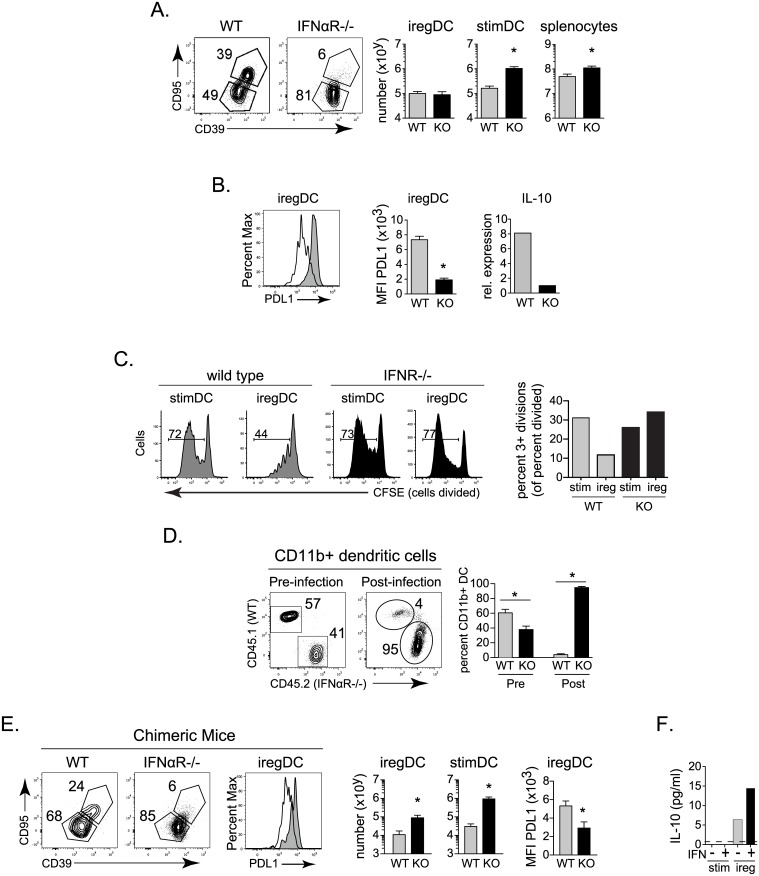
Two-pronged mechanism of IFN-I mediated immunosuppression: IFN-I programs iregDC suppressive functions and limits stimDC generation.
A. CD39 and CD95 expression by splenic CD11b+ DCs from WT and IFNαR-/- mice at day 9 after LCMV-Cl13 infection. Bar graphs indicate the number of iregDC (CD39+, CD95+), stimDC, and total splenocytes. B. Histogram shows PDL1 expression on iregDCs from WT (grey) and IFNαR-/- (white) mice. Bar graphs show quantification of PDL1 expression (MFI) and IL-10 RNA by iregDC from WT and IFNαR-/- mice at day 9 of LCMV-Cl13 infection. To obtain sufficient cell numbers for the IL-10 RNA analysis, iregDC and stimDC were sorted from a pool of 8 mice. Data for IL-10 RNA analysis show one of two experiments. C. StimDC and iregDC were FACSorted from WT or IFNR-/- mice 9 days after LCMV-Cl13 infection and co-cultured with CFSE labeled naïve LCMV-specific CD4 SMARTA T cells. No peptide was added to the cultures. Flow plots show CFSE dilution by the virus-specific CD4 T cells 5 days after co-culture. Numbers in the flow plot indicate the percent of virus-specific CD4 T cells that have diluted CFSE. The bar graph indicates the percent of virus-specific CD4 T cells that have undergone 3 or more divisions (gated on divided cells), calculated as in [21]. D. Flow plots show reconstitution of CD11b+ DCs from WT CD45.1+) and IFNαR-/- CD45.2+) lineage cells in bone marrow chimera pre-infection (blood– 9 weeks post reconstitution) and post-infection (spleen—day 9 of LCMV-Cl13 infection). Bar graph shows quantification of the percent of lineage derived CD11b+ DCs. E. Flow plots show iregDC and stimDC gated on splenic CD11b+ DCs at day 9 after LCMV-Cl13 infection of the WT: IFNαR-/- bone marrow chimera mice. Flow plots are gated on the WT and IFNαR-/- lineage from the same mouse. Histogram shows PDL1 expression on iregDCs from WT (grey) and IFNαR-/- (white) lineage cells in the same chimeric mice. Bar graph indicates the total number of iregDC and stimDC and PDL1 MFI from each lineage in the chimeric mice. F. Bar graph shows IL-10 expression in the supernatant of sorted CD11b+ DC after stimulation with media alone or IFNβ. Supernatants were harvested 24 hours after culture. Data are representative of 2 or more independent experiments each consisting of 3–4 mice per group. *, p<0.05. For the WT vs IFNR-/- DC co-culture with T cells (Fig 3C), data are shown from 1 of 2 experiments each using samples pooled from 10–15 mice per DC group to obtain adequate numbers of each DC population.